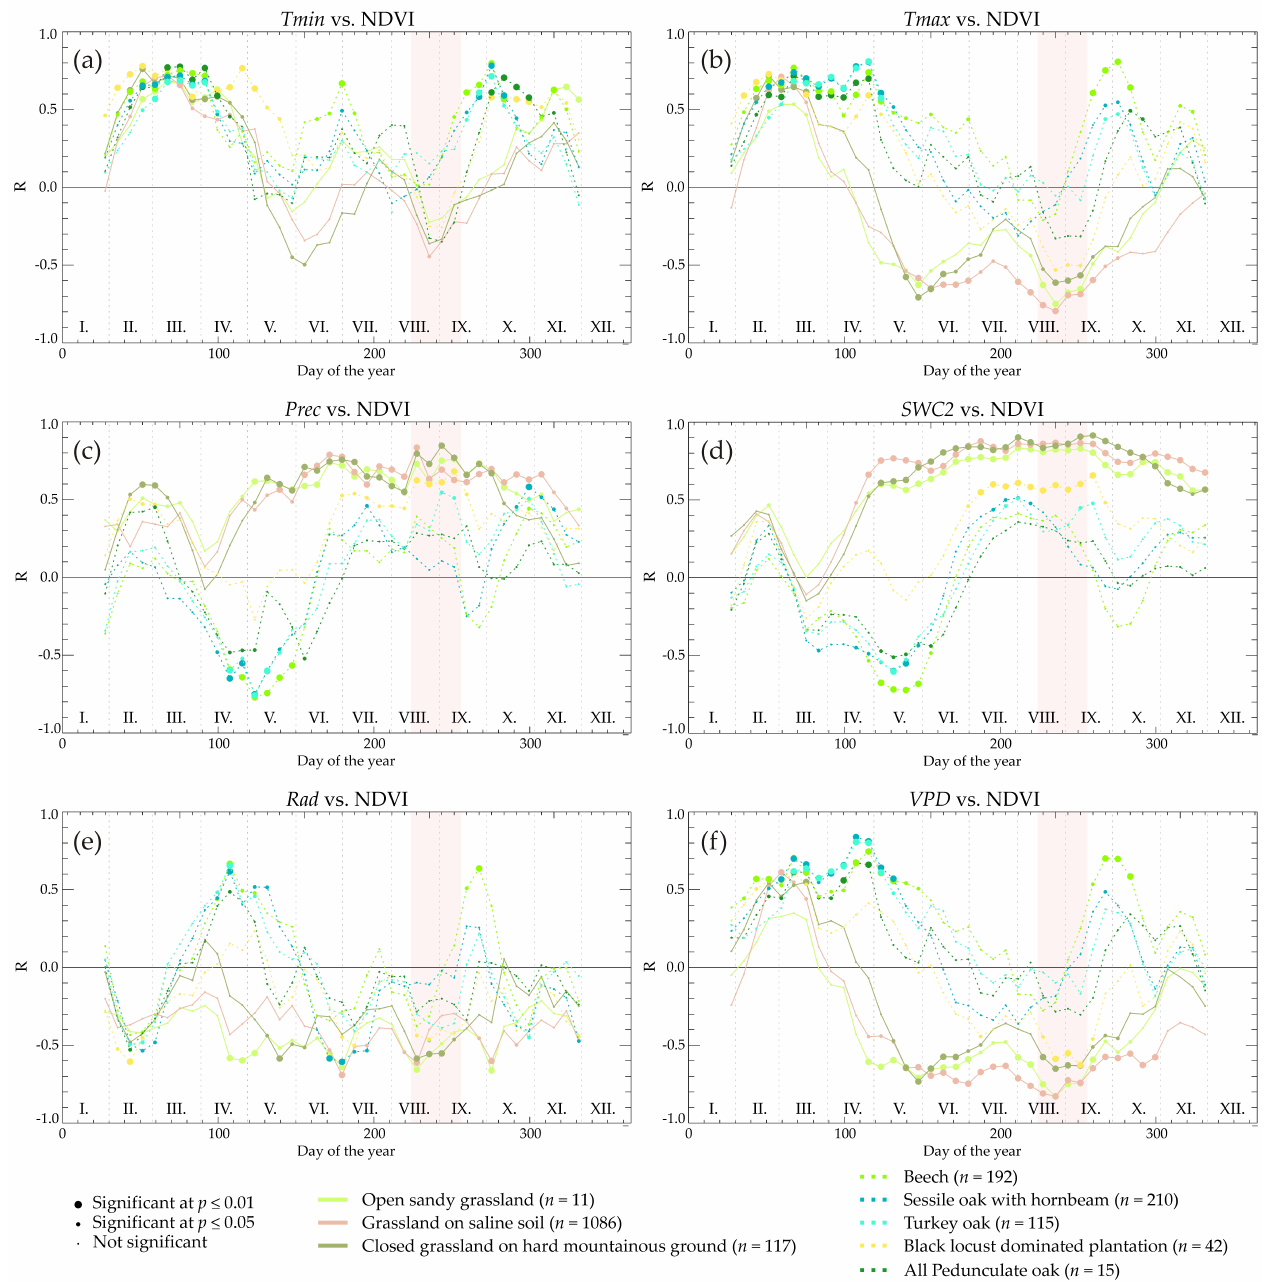
Figure 5. Pearson’s R -values between the area-averaged NDVI (after the indicated period) and the area-averaged climate variables (before the indicated period) separately ( a – f ). Both the NDVI and the climate variables refer to 32-day-long intervals, with an 8-day overlap. Pink rectangles indicate the period of interest (PI) in late